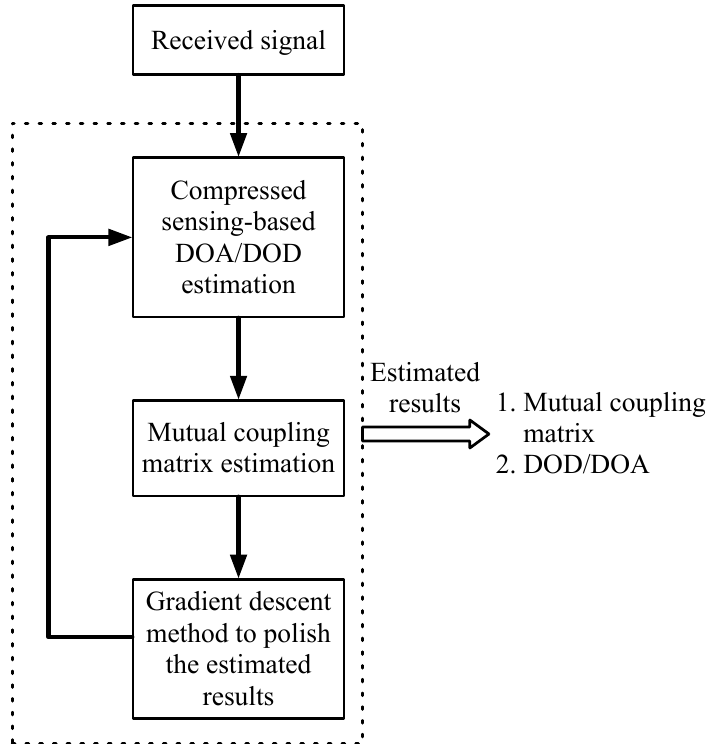
Figure 3. The flow chart of proposed method for DOD/DOA estimation with the unknown mutual coupling